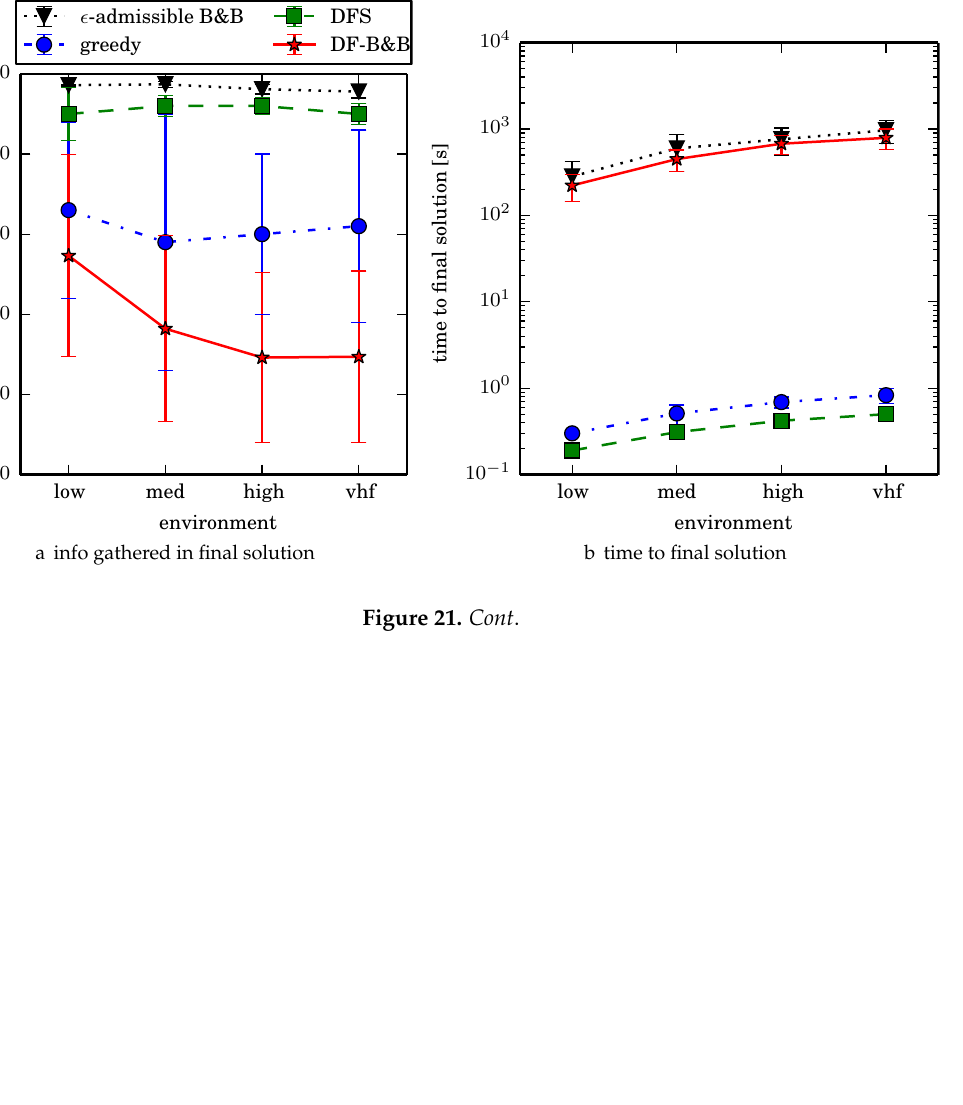
Figure 20. Results for Experiment 3 in uniform environment. See Table 2 for more detailed figures.